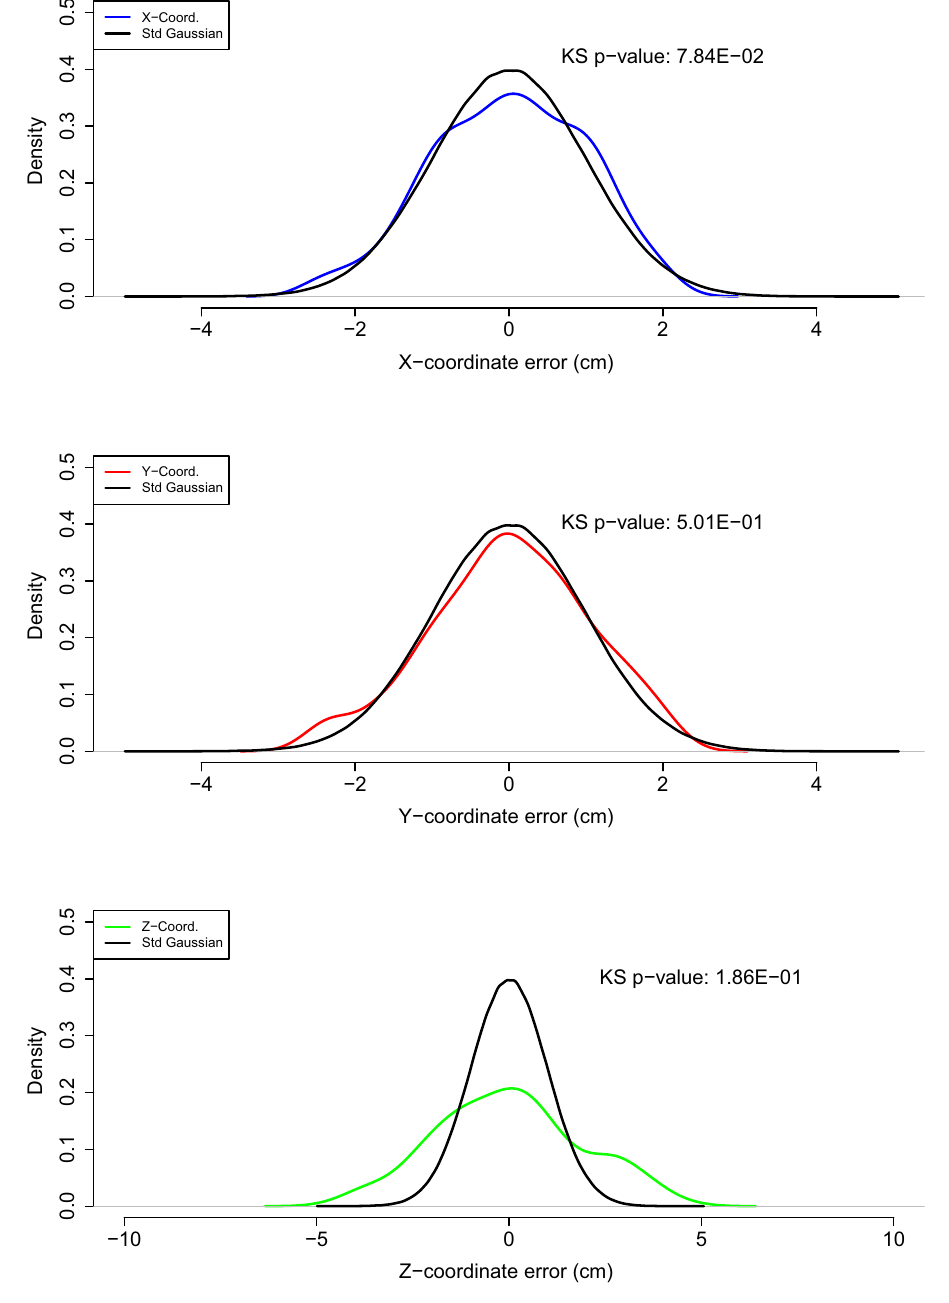
Fig. 13 Distributions of coordinates based on 5 min of undisturbed data. Top panel shows the X coord. distribution along with a best fit of a zero- centered Gaussian. Middle and Bottom panel show the same, for the Y and Z coordinates